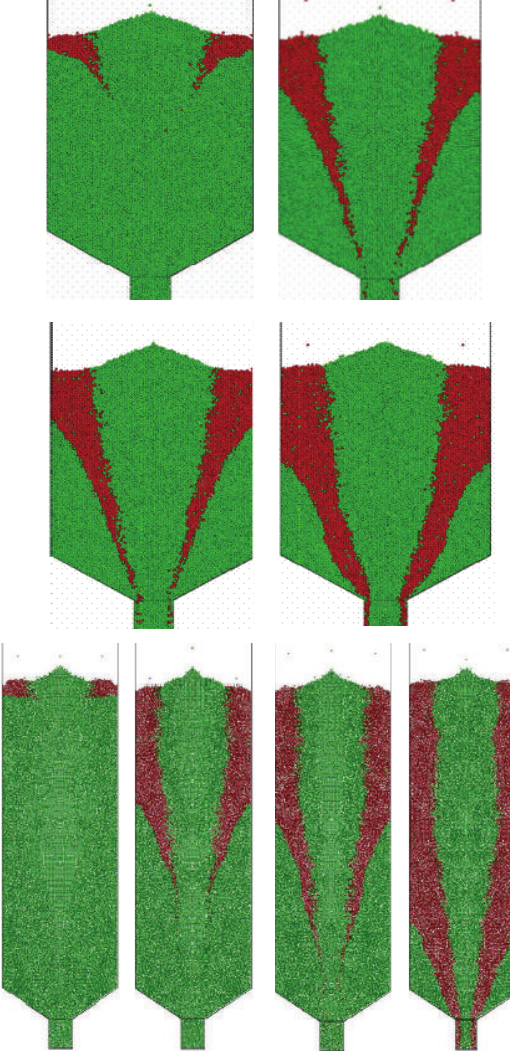
Figure 6: DEM simulation of stagnant zone on different bed height from ℎ = 75 d to ℎ = 160 d ( 𝑓 = 0.2 , 𝐴 = 30 ∘ ).